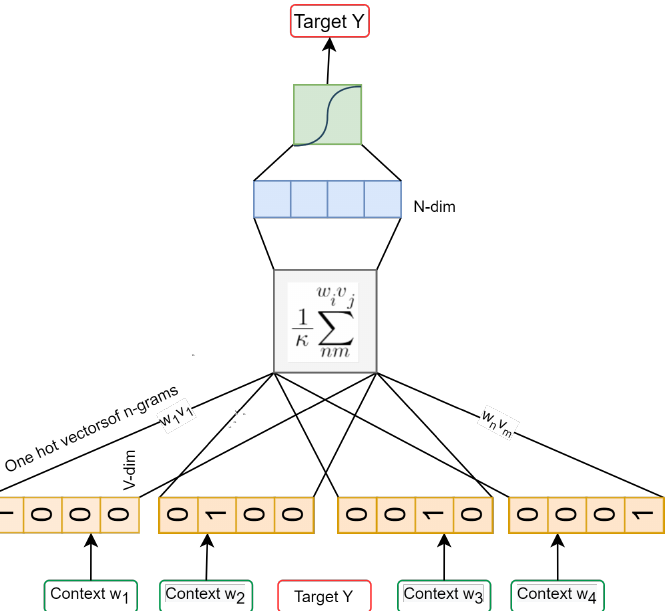
Figure 5. Roman Urdu word representations using continues bag of words model of